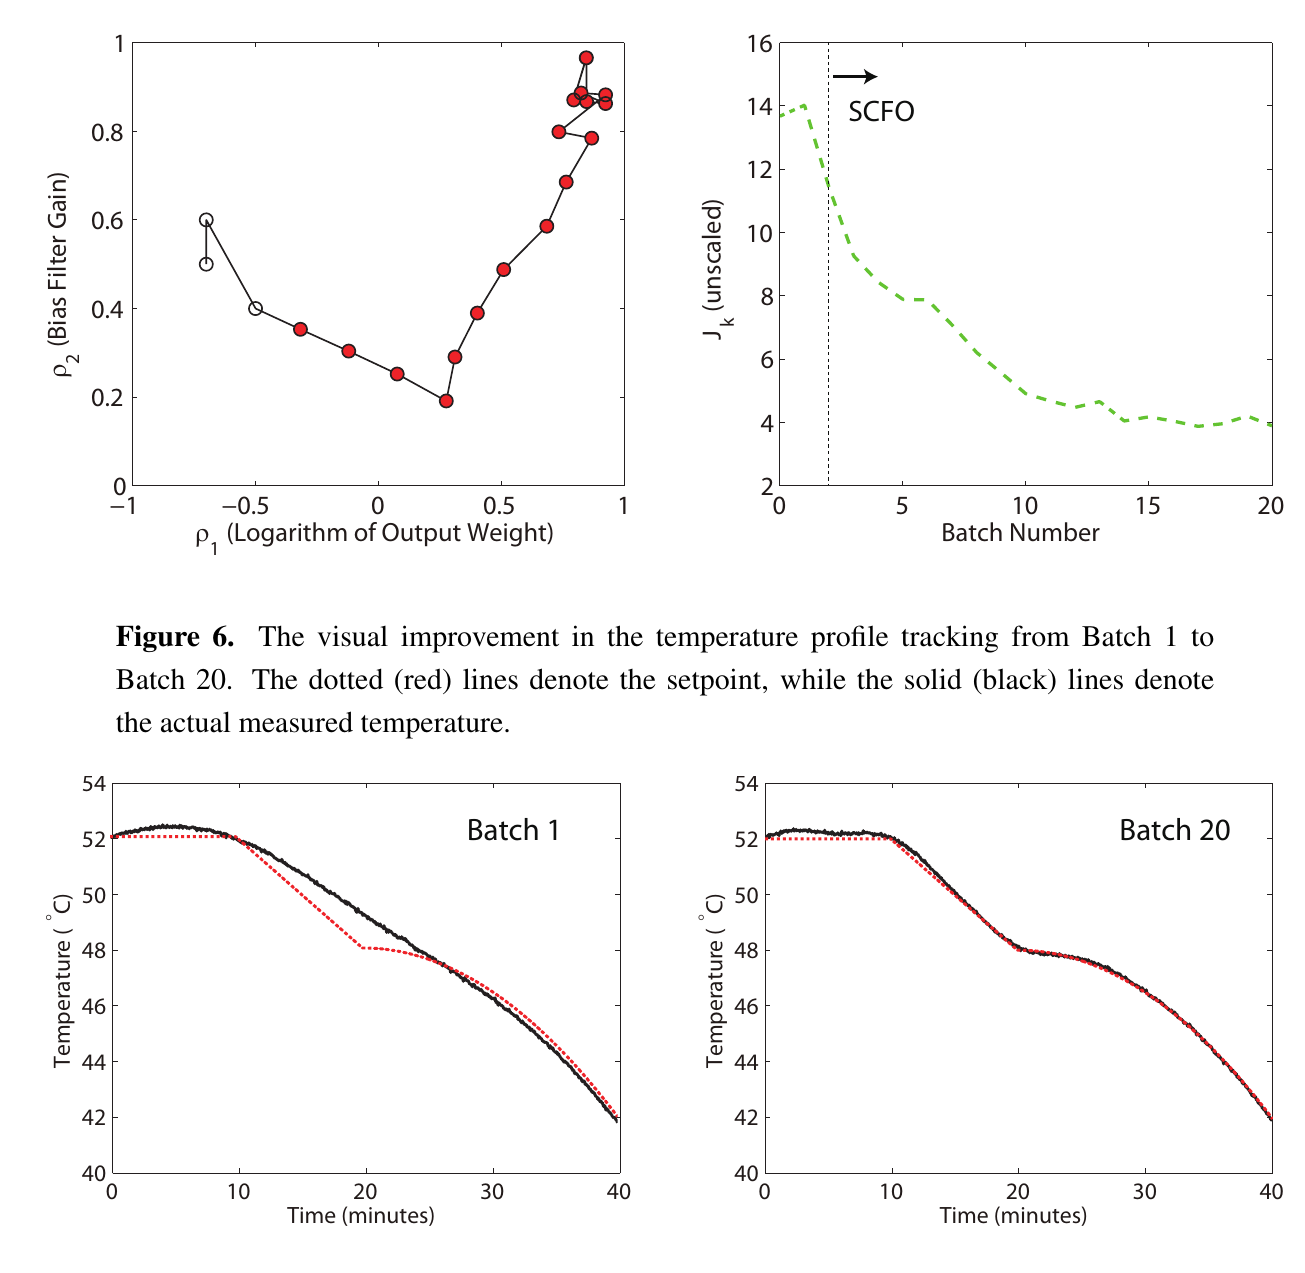
Figure 5. The parameter adaptation plot (left) and the measured performance metric (right) for the solution of Problem (18). Hollow circles on the left indicate batches that were carried out as part of the initialization (prior to applying the solver). Likewise, the dotted vertical line on the right shows the iteration past which the parameter adaptations were dictated by the SCFO solver.